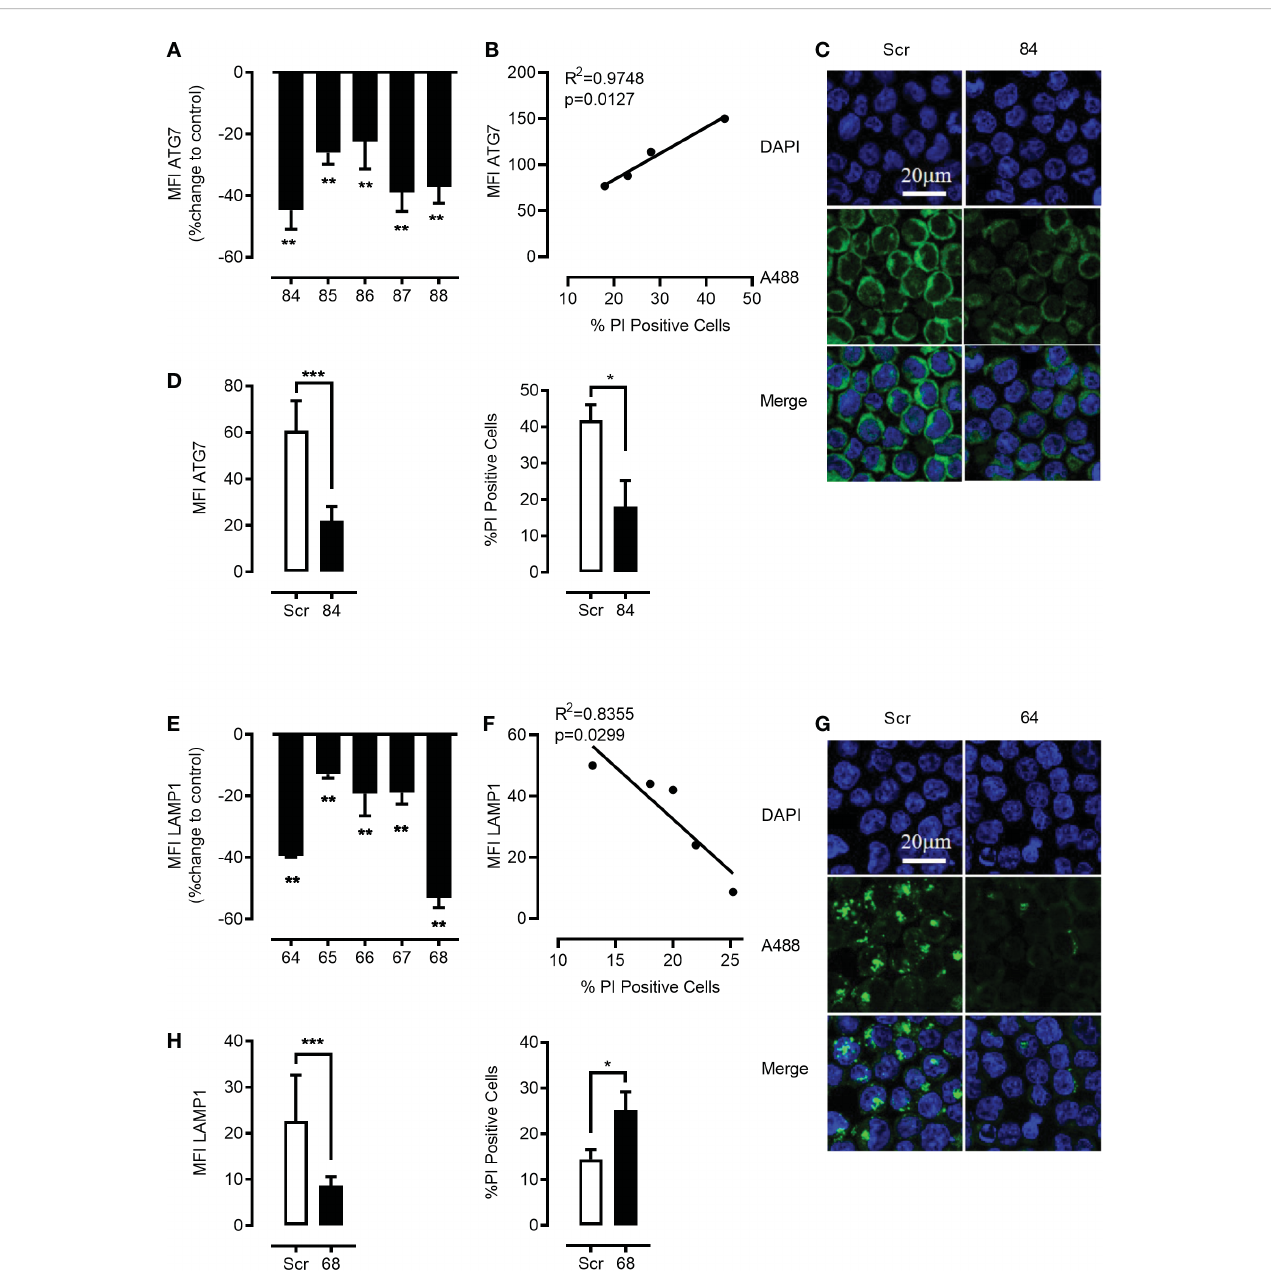
FIGURE 6 Genetic targeting of ATG7 using shRNA rescues the cell from the toxic effects of the synergistic combination of mTOR inhibition and lysosome disruption. K562 cells were lentivirally transduced with 5 different shRNA plasmids (84 – 88) to knock down ATG7 protein. Flow cytometric analysis of intracellular staining of ATG7 showed that there was a signi fi cant knockdown of ATG7 in all the shRNA targets with a maximum knockdown in plasmid no. 84 (A) when compared to scrambled controls. Data represent mean ± S.D. and is representative of 2 independent experiments each with 2-3 replicates. Linear correlation analysis revealed a negative correlation between cell death and the down-regulation of ATG7 (B) . Knockdown was further con fi rmed using confocal microscopy (C) . The Green channel is for Alexa Fluor 488 (secondary antibody to ATG7 protein) and the blue is for DAPI (nuclear stain). Images are representative of two independent experiments with more than 3 images taken randomly per condition per experiment. (D) left panel Flow cytometric analysis of intracellular staining of ATG7 showed that there was signi fi cant knockdown of ATG7 in plasmid no. 84 when compared to scramble control. Selected cells harboring plasmid no. 84 were subjected to pp242 (5µM) and me fl oquine (10µM) treatment for 24 h and cell viability was measured using PI. ATG7 knockdown cells had a signi fi cantly lower percentage of cell death when compared to scrambled control (D) right panel . K562 cells were lentivirally transduced with 5 different shRNA plasmids (64-68) to knock down LAMP1 protein. Flow cytometric analysis of intracellular staining of LAMP1 showed that there was a signi fi cant knockdown of LAMP1 in all the shRNA targets with a maximum knockdown in plasmid no. 68 (E) when compared to scrambled controls. Data represent mean ± S.D. and is representative of 2 independent experiments each with 2-3 replicates. Linear correlation analysis revealed a positive correlation between cell death and the down-regulation of LAMP1 (F) . Knockdown was further con fi rmed using confocal microscopy (G) . The Green channel is for Alexa Fluor 488 (secondary antibody to LAMP1 protein) and the blue is for DAPI (nuclear stain). Images are representative of two independent experiments with more than 3 images taken randomly per condition per experiment. (H) left panel ) Flow cytometric analysis of intracellular staining of LAMP1 showed that there was a signi fi cant knockdown of LAMP1 in plasmid no. 68 when compared to scramble control. Selected cells harboring plasmid no. 68 were subjected to me fl oquine (10µM) treatment for 24 h and cell viability was measured using PI. LAMP1 knockdown cells had a signi fi cantly higher percentage of cell death when compared to the scrambled control (H) right panel . Data are presented as mean ± S.D. *p < 0.05, **p < 0.01, ***p < 0.001 by One-way ANOVA with Dunnett ’ s multiple comparison test (A, E) or student ’ s t test (D, H) *P < 0.05; **P < 0.01; ***P <